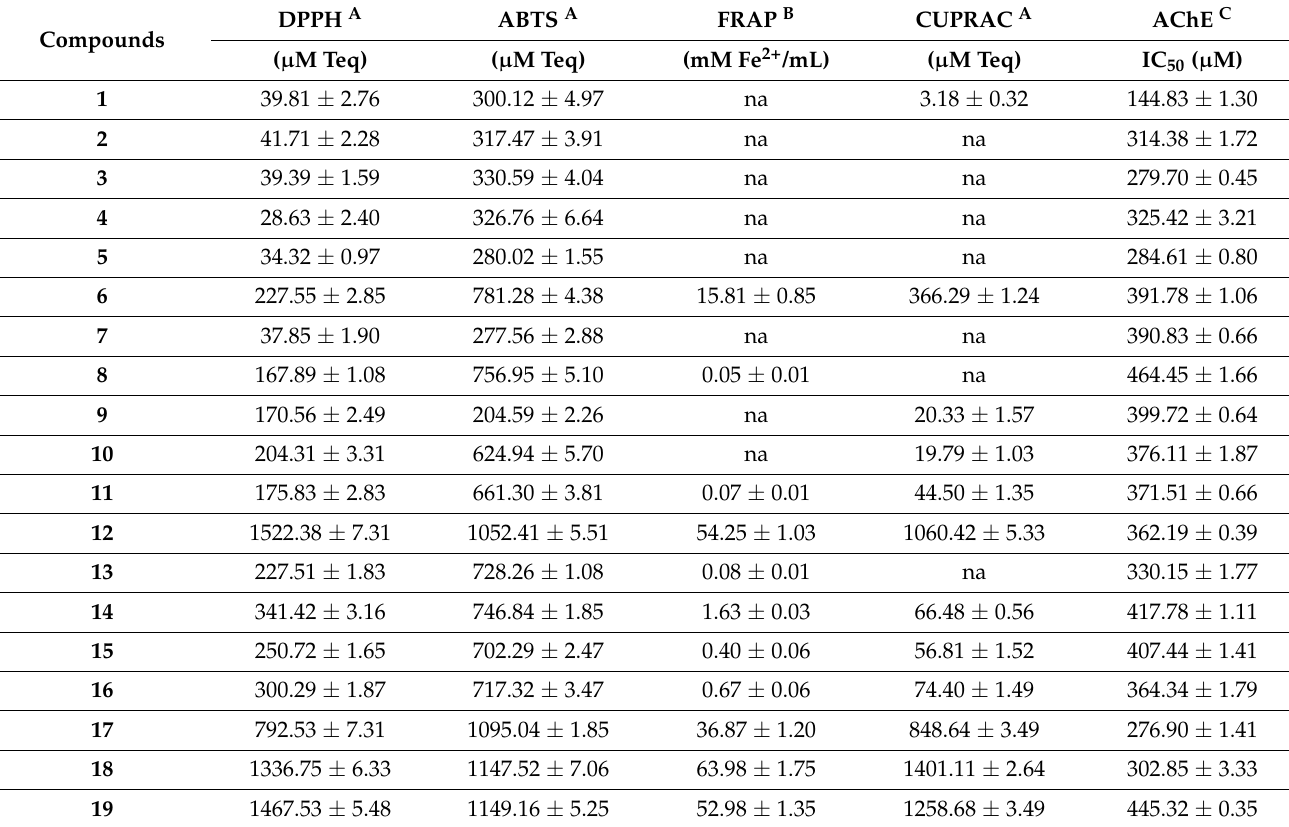
Table 5. Antioxidant and acetylcholinesterase inhibitory activities of compounds 1–19